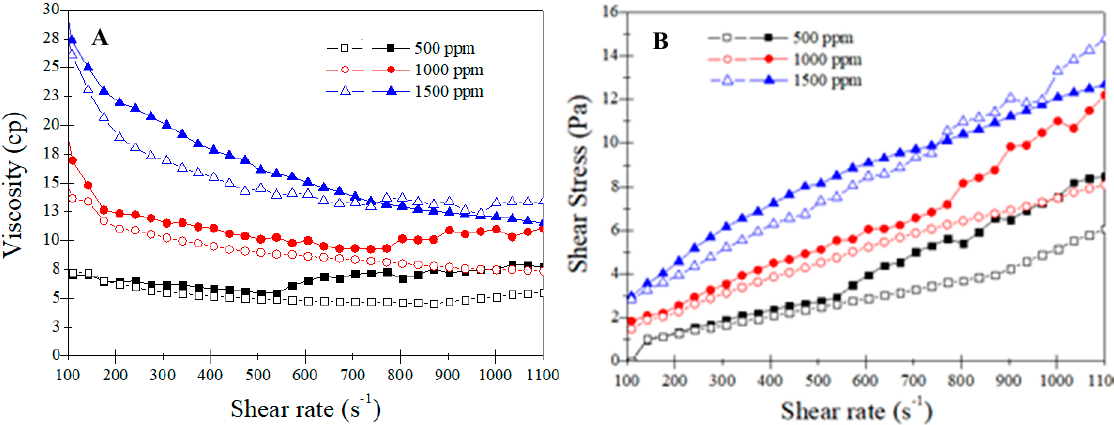
Figure 2. ( A ) Shear viscosity and ( B ) shear stress versus shear rate for B192 (open) and Flopaam 3630S (closed).